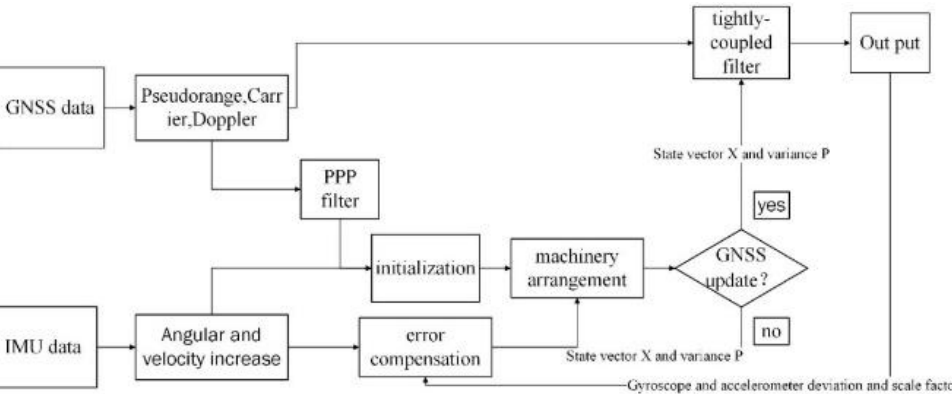
Figure 1 . PPP/INS tightly-coupled navigation algorithm structure